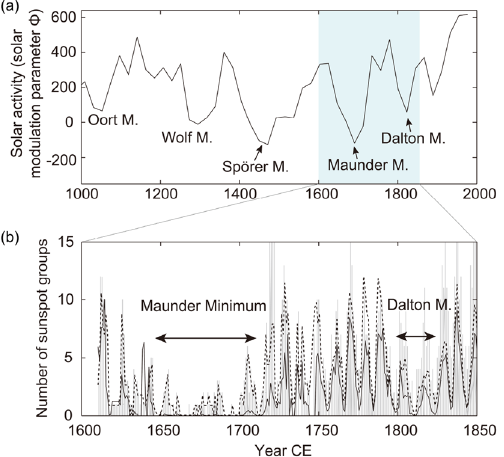
Figure 1. Long-term solar activity during the past millennium. ( a ) Solar activity level reconstructed based on multiple records of cosmic ray induced nuclides 2 . Downward peaks indicate the deep minima in solar activity when the number of sunspots significantly decrease or even disappear from the solar surface. ( b ) Number of yearly mean sunspot groups around the Maunder Minimum (1645–1715 CE) and the Dalton Minimum (1800–1824 CE) obtained by Hoyt and Schatten 4 (solid line) and by Svalgaard and Schatten 5 (dashed line), and the number of daily sunspot groups by Vaquero et al. 6 (gray line) for the same